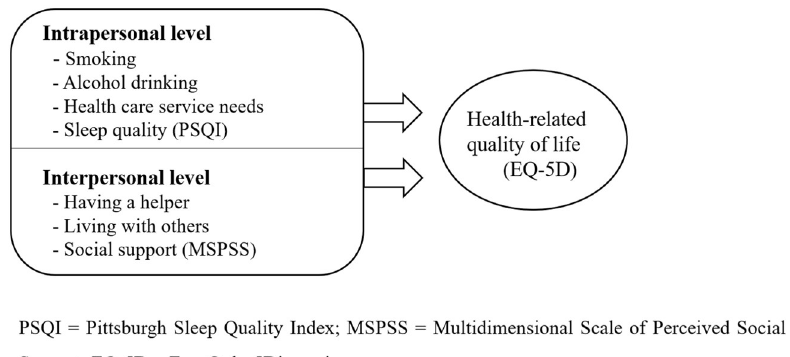
Figure 1. Conceptual model for predicting health-related quality of life in older adults. Aims